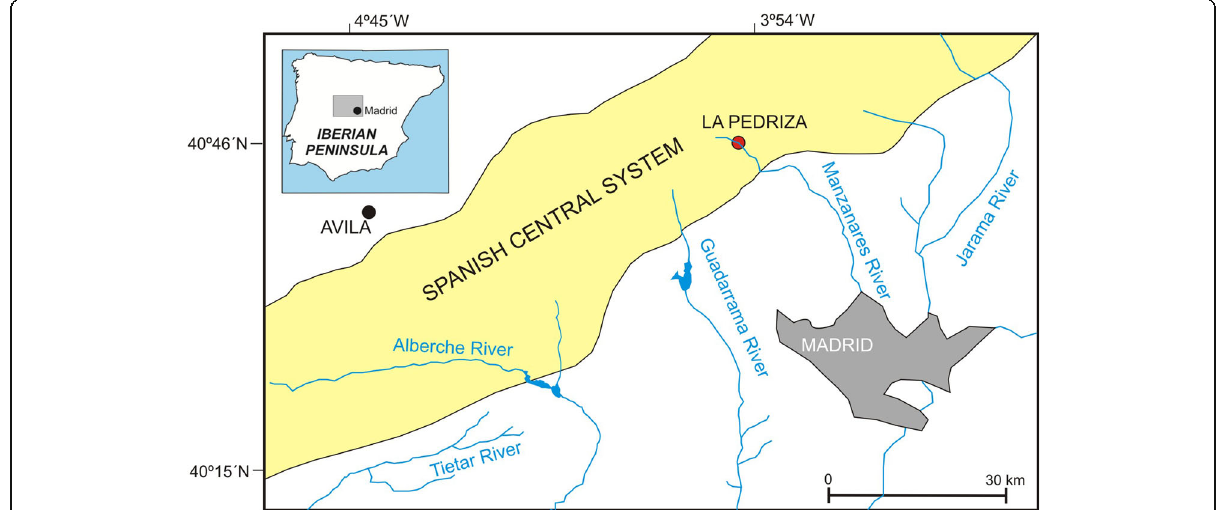
Fig. 6 Location map of La Pedriza in the Spanish Central System mountain